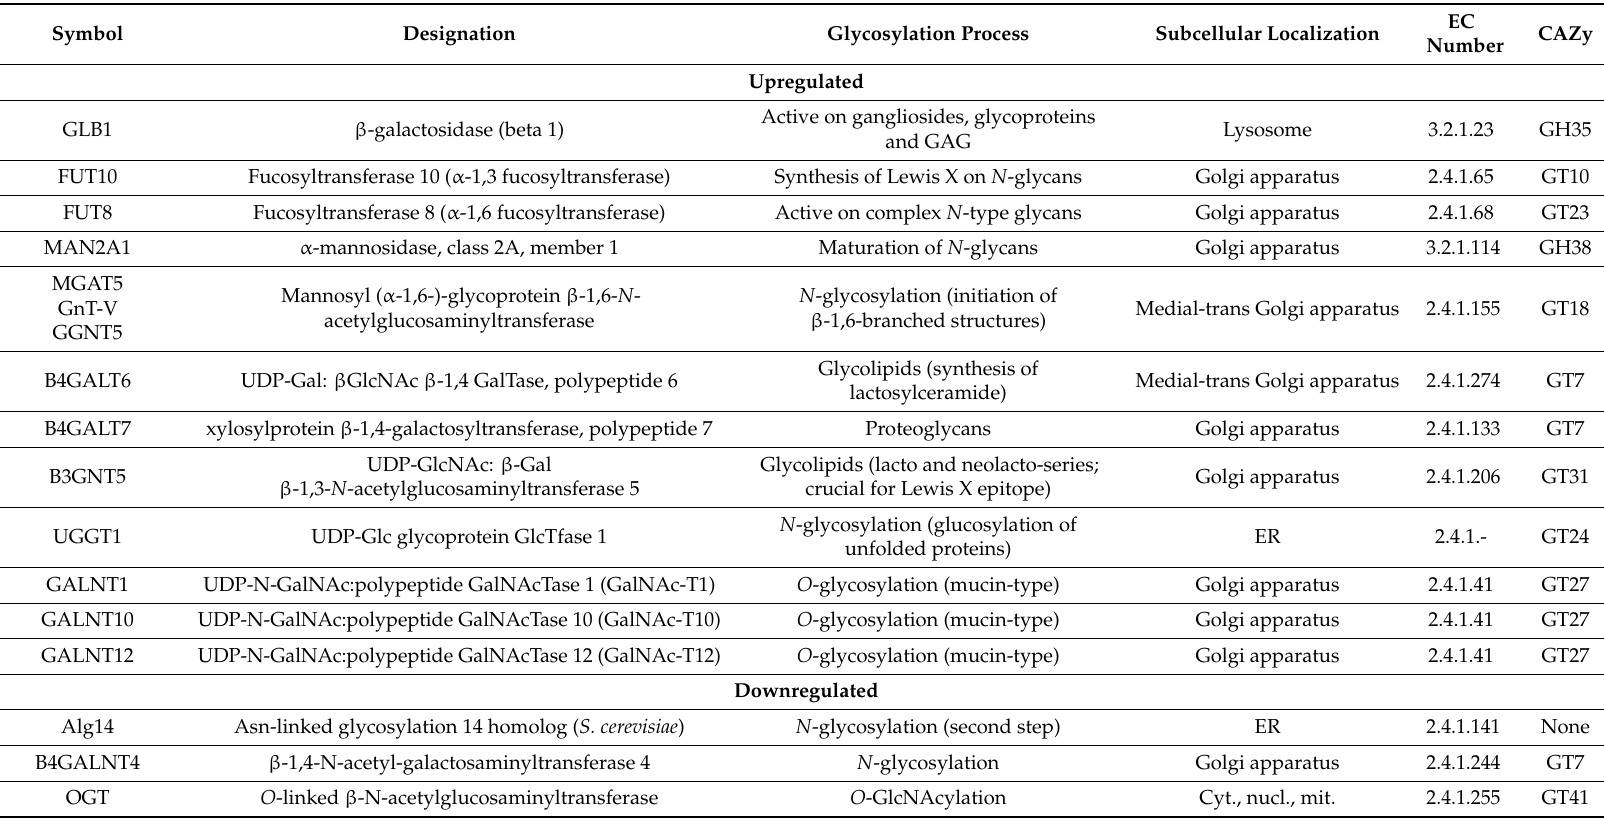
Table 2. Genes involved in glycosylation that are up- or down-regulated upon OGT depletion (from data published in Vella et al.